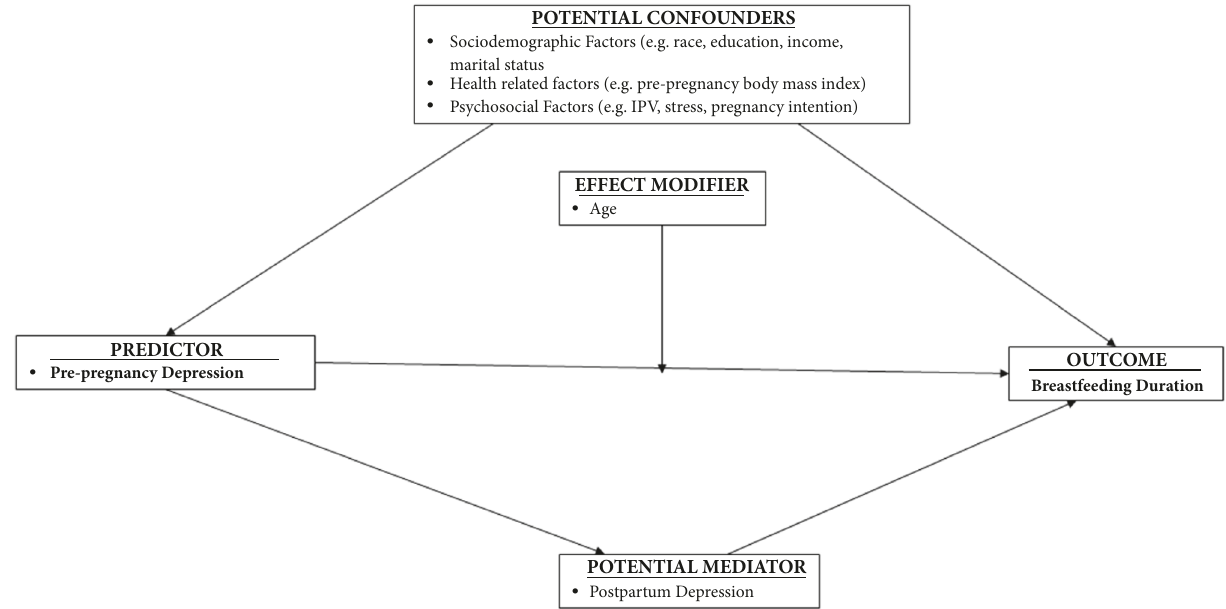
Figure 1: Directed acyclic graph of prepregnancy depression and breastfeeding